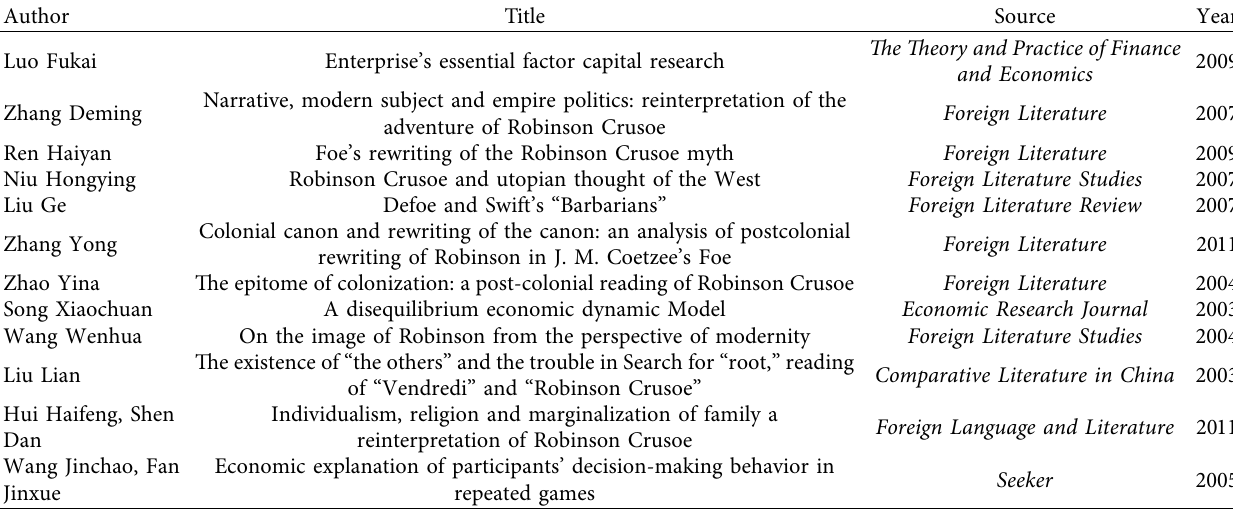
Table 3: The Top 10 cited